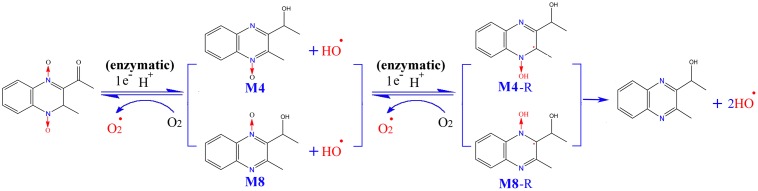
The proposed metabolic pathways of MEQ in male mouse to better understand the higher reproductive toxicity of M4 compared to M8. The production of M4-R and M8-R intermediate radicals, as well as O2•- and OH• occurs via reduction of the N→O group of MEQ. Close to an electron on the quinoxaline ring, a methyl and a hydroxyl were found in M4-R, while two hydroxyl groups were noted in M8-R.